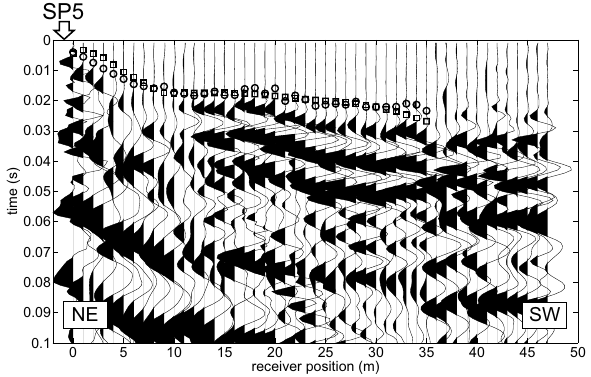
Fig. 7. Example shot gather recorded from shot point 5 (SP5), which was located on a talus deposit (the shot point location is shown on the seismic tomogram in Fig. 8). Circles are observed first-break picks and squares are calculated travel-times from the inverted velocity